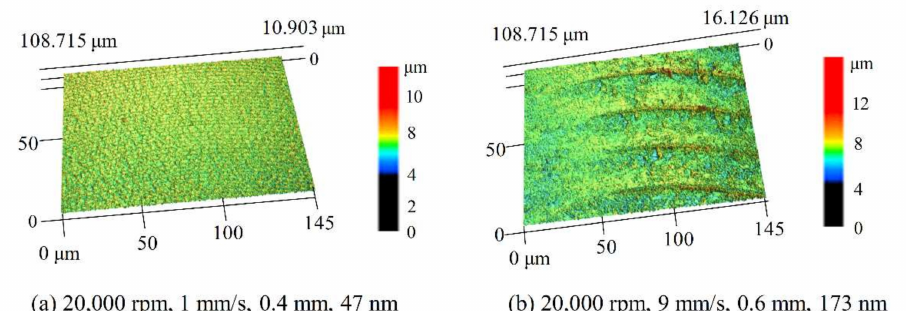
Figure 3. Grove bottom surface morphology with di ff erent processing parameters: spindle speed-feed rate-cutting depth-surface roughness ( a ) 20,000 rpm, 1 mm / s, 0.4 mm, 47 nm; ( b ) 20,000 rpm, 9 mm / s, 0.6 mm, 173 nm. (The results were measured by the laser scan confocal microscope (VK-X250, Keyence Co., Osaka, Japan) with a 20 × microscope